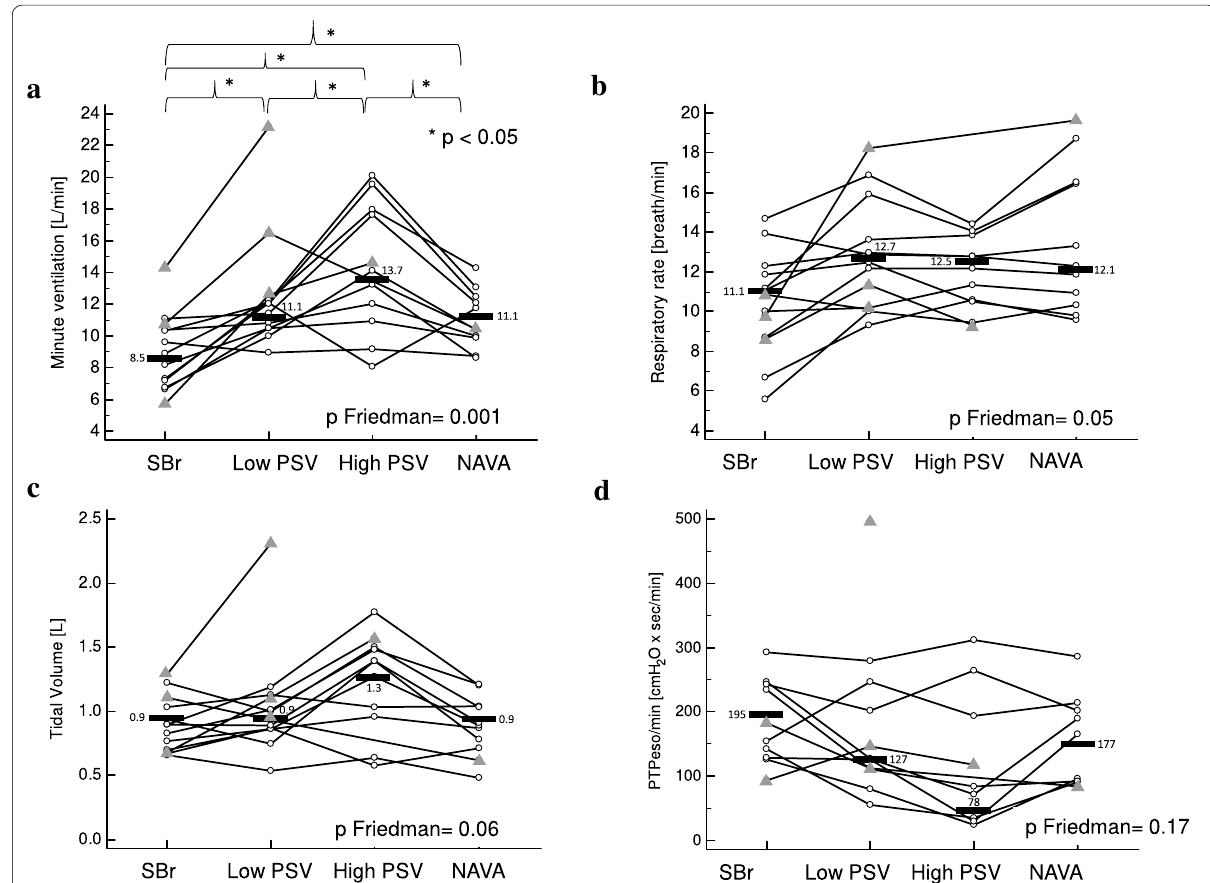
Fig. 6 Effect of stressed assisted ventilation on MV ( a ), RR ( b ), VT ( c ) and PTPeso/min ( d ). MV minute ventilation, RR respiratory rate, VT tidal volume, PTPeso/min esophageal pressure–time product by minute. SBr spontaneous non‑assisted breathing in the presence of the resistance, PSV pressure support ventilation. NAVA neurally adjusted ventilatory assist. The data of all the participants are displayed in the figure. Patients for whom all the conditions were available are represented as white circles. Patients for whom one or more conditions could not be recorded are represented as gray triangles. Only the patients represented as white circles were considered for median calculations and Friedman